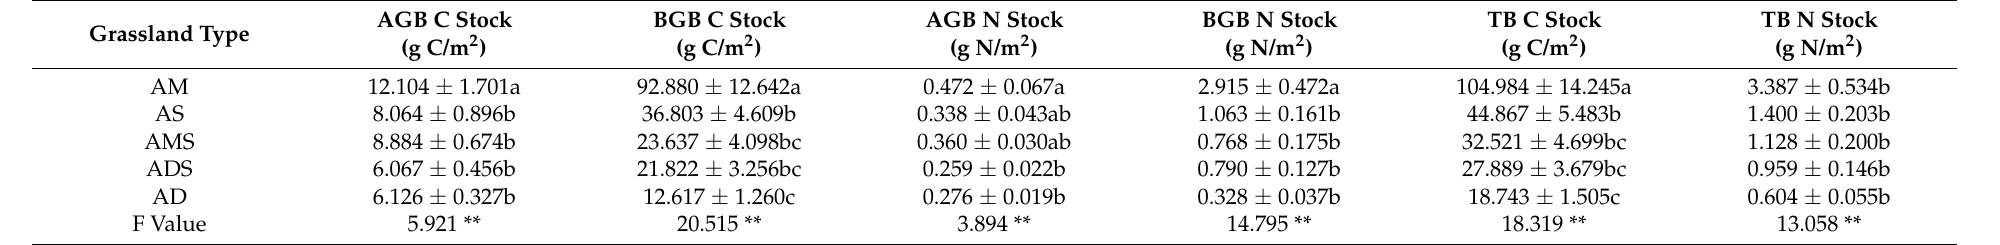
Table 4. Nitrogen (N), carbon (C) stocks of aboveground biomass (AGB), belowground biomass (BGB) and total biomass (TB) in 5 alpine grassland